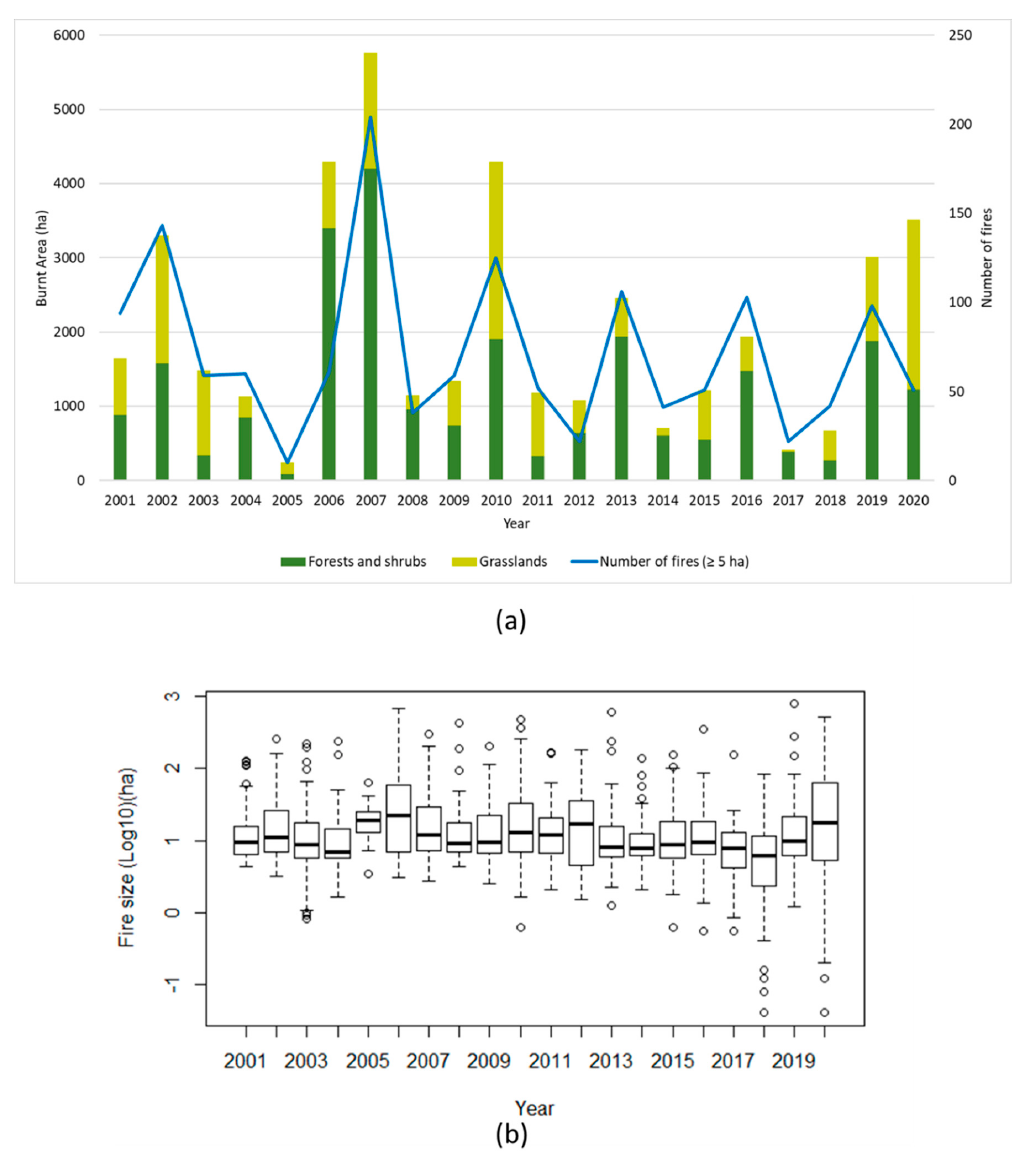
Figure 6. ( a ) the annual number of fires (blue) and burnt area (BA) (Y-axis) in forest/shrublands (dark green) and grasslands (light green); ( b ) boxplots representing the yearly median, standard deviation, 95% confidence interval and outliers of fire size (Y-axis, log10scale, ha) in Lebanon for the period 2001–2020.